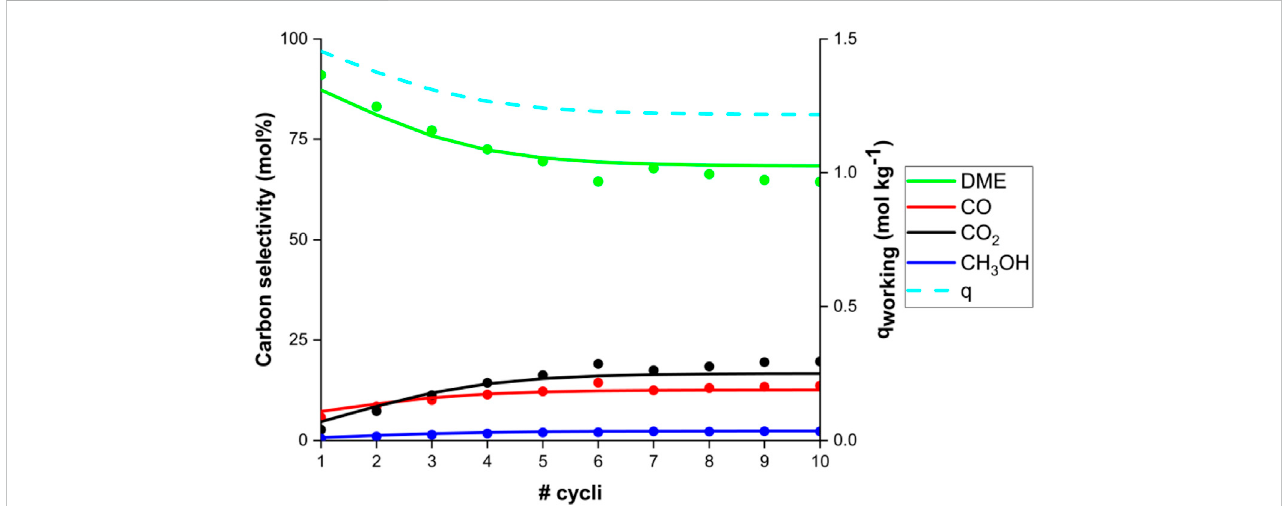
FIGURE 6 Experimental carbon selectivity (dots) to DME (green), CO (red), CO 2 (black) and methanol (blue) and model prediction (lines) as function of the number of subsequent cycles. The model working capacity q (dashed blue line) is shown on the right axis. Conditions: 220 ° C and 25 bar(a) for a CO 2 feed with stoichiometric hydrogen, with argon tracer.